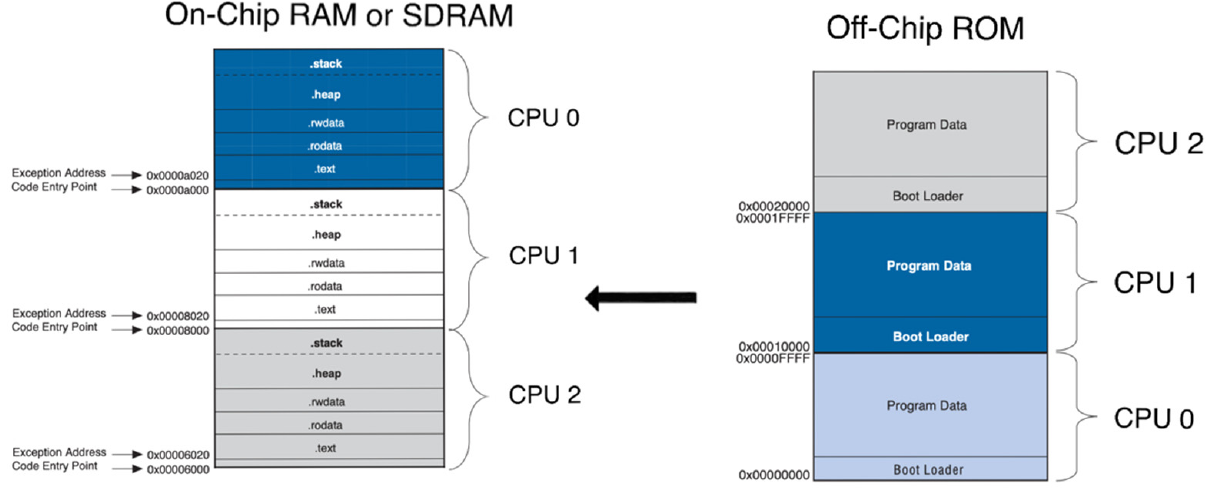
Figure 10. The memory space of a 3-core multi-NIOS II application.